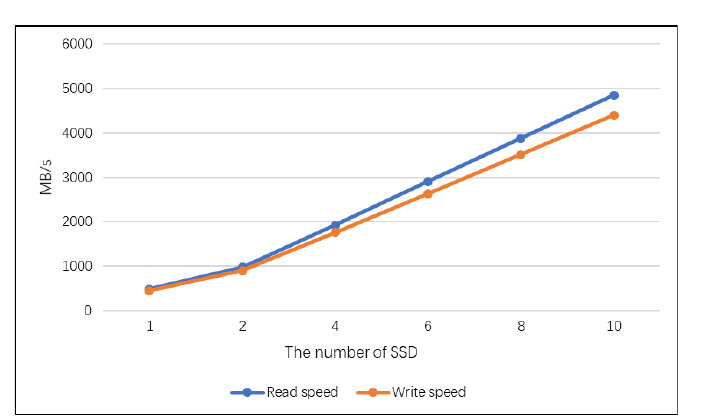
Fig. 1. Average read or write speed of multiple